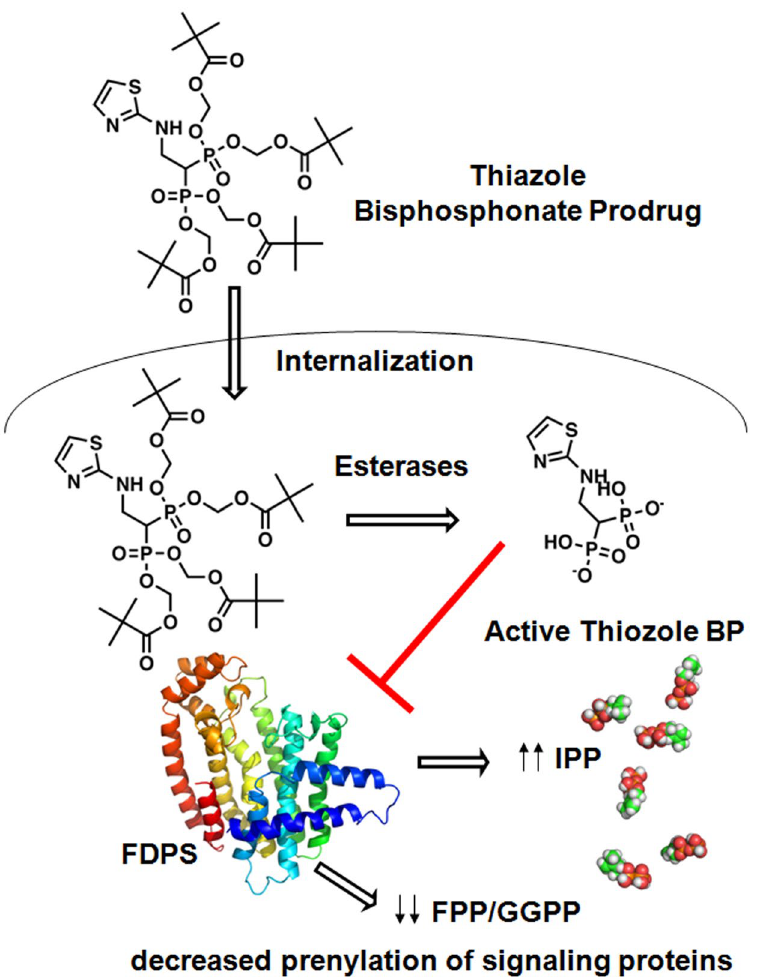
Figure 1. Schematic diagram of intracellular conversion of bisphosphonate pivoxil prodrugs to their corresponding acids. Bisphosphonate prodrugs are taken up by tumor cells where intracellular esterases remove their pivaloyloxymethyl moieties to yield their acid forms. The active acid forms inhibit FDPS resulting in increases in an upstream metabolite, IPP, that stimulate V γ 2V δ 2 T cells and decreases in downstream farensyl diphosphate and geranylgeranyl diphosphate resulting in decreased prenylation of signaling proteins inhibiting tumor cell growth and